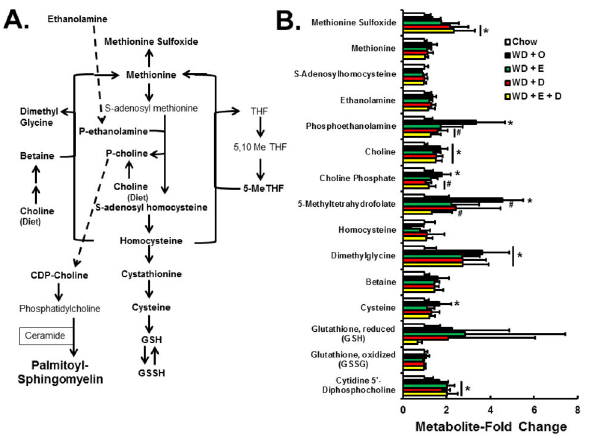
Figure 6. Diet effects on sphingolipid metabolites and enzymes involved in sphingolipid synthesis. Pathway for de novo sphingomyelin synthesis. Panel B: Hepatic palmitoyl-sphingomyelin and metabolites involved in sphingomyelin synthesis (sphinganine) and ceramide group. Panel C: RNA expression of key enzymes involved in sphingomyelin synthesis; mean ± SD. [serine-palmitoyl transferase long chain base subunit-1 & 2 (SPTLC1 & 2) and phosphatidylcholine:ceramide choline phosphotransferase 1 &